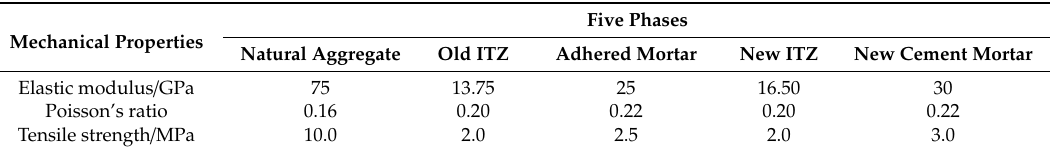
Table 2. Mechanical properties of the five-phase system.